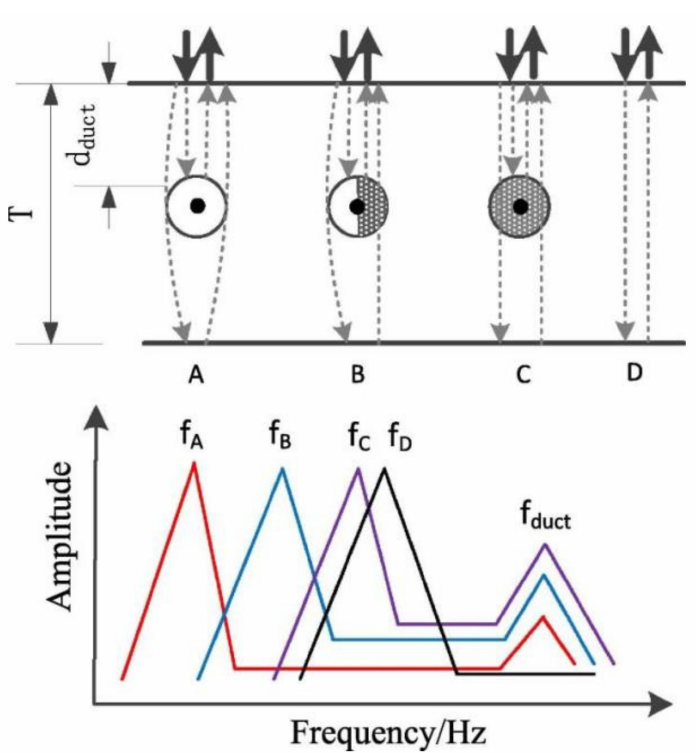
Figure 4. Diagrammatic sketch of IE method [25]. (The interior of A is empty pipe, the interior of B is half-empty and half-grouting, the interior of C is full grouting and the interior of D is dense concrete